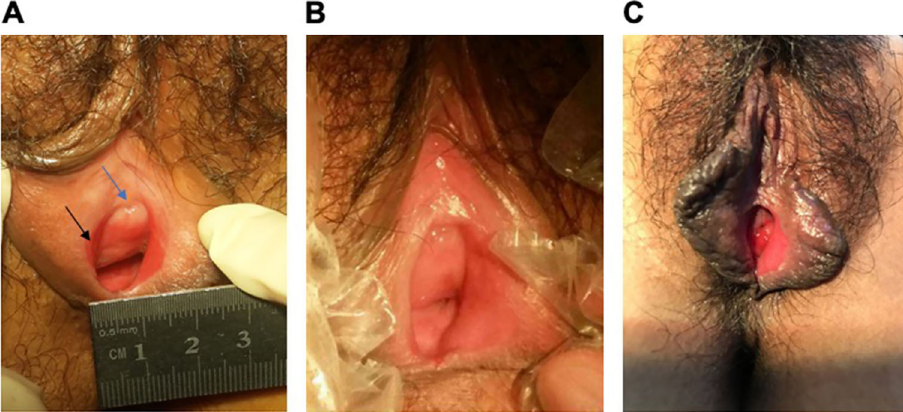
Figure 3 . A , The medial mucosal surfaces of the labia minora had bright red-colored, defect-like lesions, and the vaginal ori fi ce was stenosed with a diameter of 1 cm. Blue arrow: narrow urethral ori fi ce; Black arrow: defect of the mucosa. B , The medial mucosa of the labia minora was smooth and slightly reddened, and the vaginal opening was slightly narrowed. C , The mucosa of the medial labia minora was slightly reddened, smooth, and without